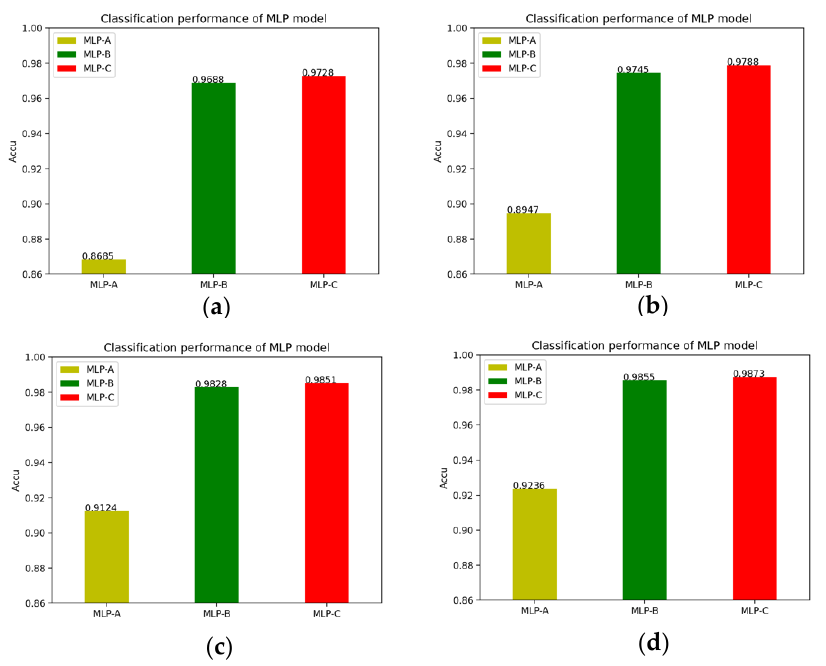
Figure 13. ( a ) No attention mechanism is added to models; ( b ) Models add self-attention mechanism; ( c ) Models add external-attention mechanism and Softmax; ( d ) Models add external-attention mechanism and double normalization.